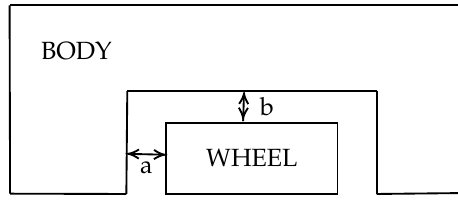
Figure 6. Cavity dimensions [17].